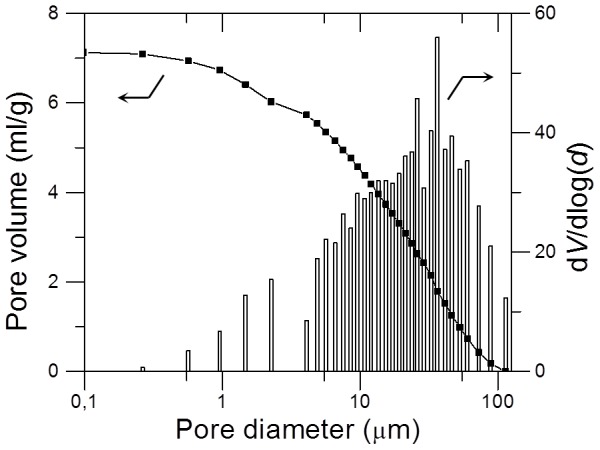
Mercury porosity analysis.The cumulative pore volume (line with markers) and derivative pore size distribution (vertical columns) of PLCL300 foam prepared at −80°C for 30 s (pore range: 0.2 to 116 µm).